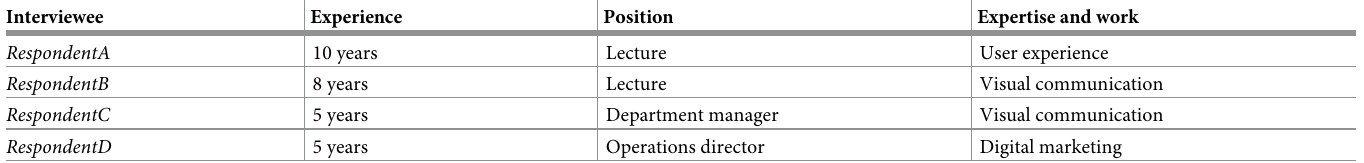
Table 1. Composition of focus group